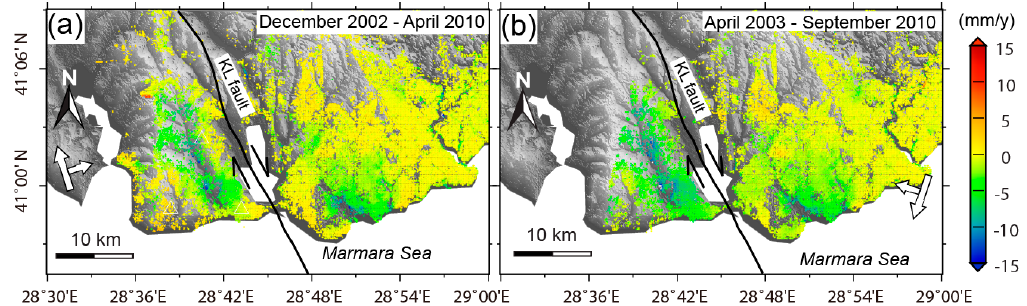
Figure 3. Persistent scatterers (PS)-InSAR velocity in the LOS (line of sight) direction for ascending ( a ) and descending geometry ( b ). Positive means that the ground points move toward the satellite.